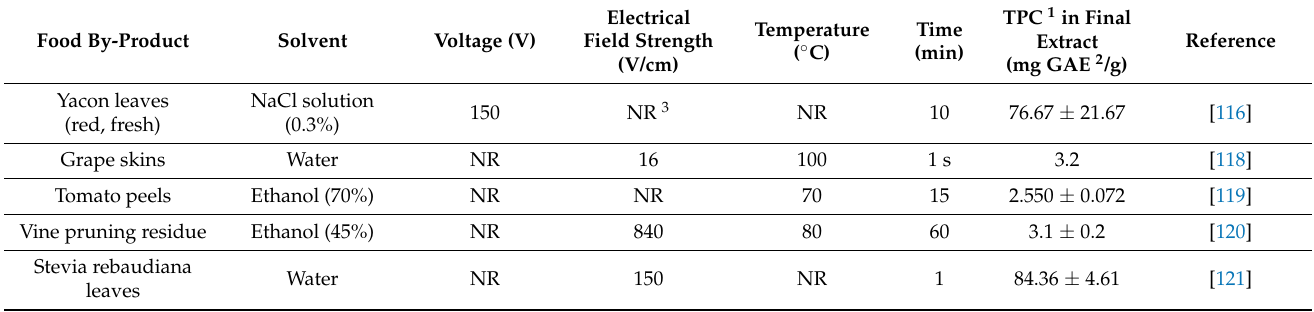
Figure 8. Simplified schematic of extraction of polyphenols using OH pretreatment. Table 5. Recovery of polyphenols from various food by-products using OH